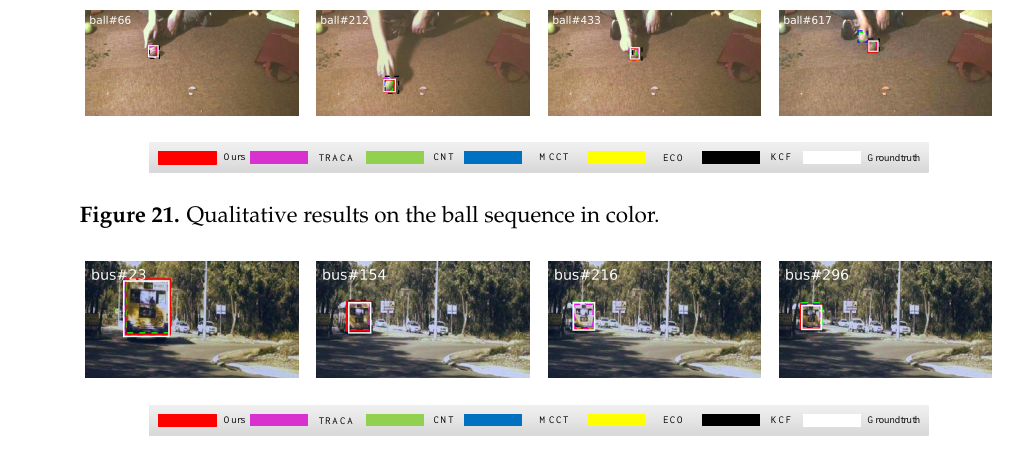
Figure 22. Qualitative results on the bus sequence in color.